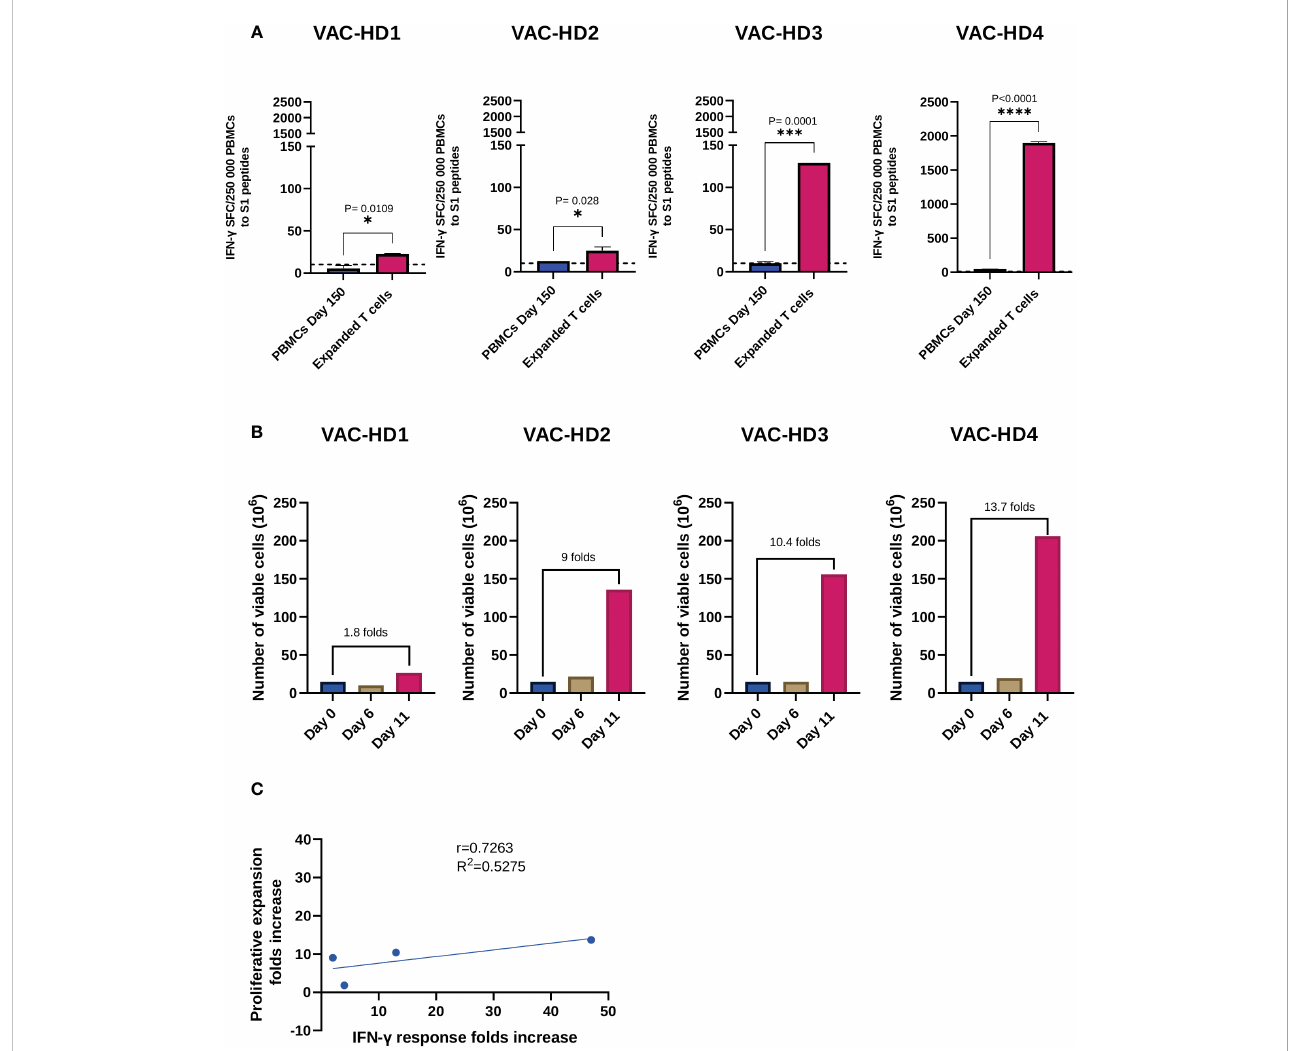
FIGURE 4 Expansion and functional characterization of expanded spike-speci fi c T cells. (A) IFN- g secretion by pre-expansion PBMCs collected 150 days post- vaccination and spike-speci fi c expanded T cells following S1 peptide pools overnight stimulation. Results are presented as the mean of the number of spots forming cells (SFCs) per 250 000 PBMCs subtracting the background (negative control) count. A positive response was de fi ned as an SFCs of 10 or more. Student t test was used, P value was considered statistically signi fi cant when *P ≤ 0.05. All samples were run in duplicates. (B) Viable cell counts, and fold expansion were assessed on days 0, 6, and 11 of expansion using trypan blue exclusion dye. (C) Correlation between IFN- g response folds increase and the proliferative expansion folds increase between pre-expansion PBMCs and spike-speci fi c expanded T cells in four BNT162b2 vaccinated participants. The dotted lines represent con fi dence intervals at 95%. The stars present the level of signi fi cance. *P < 0.05; **P < 0.01; ****P <